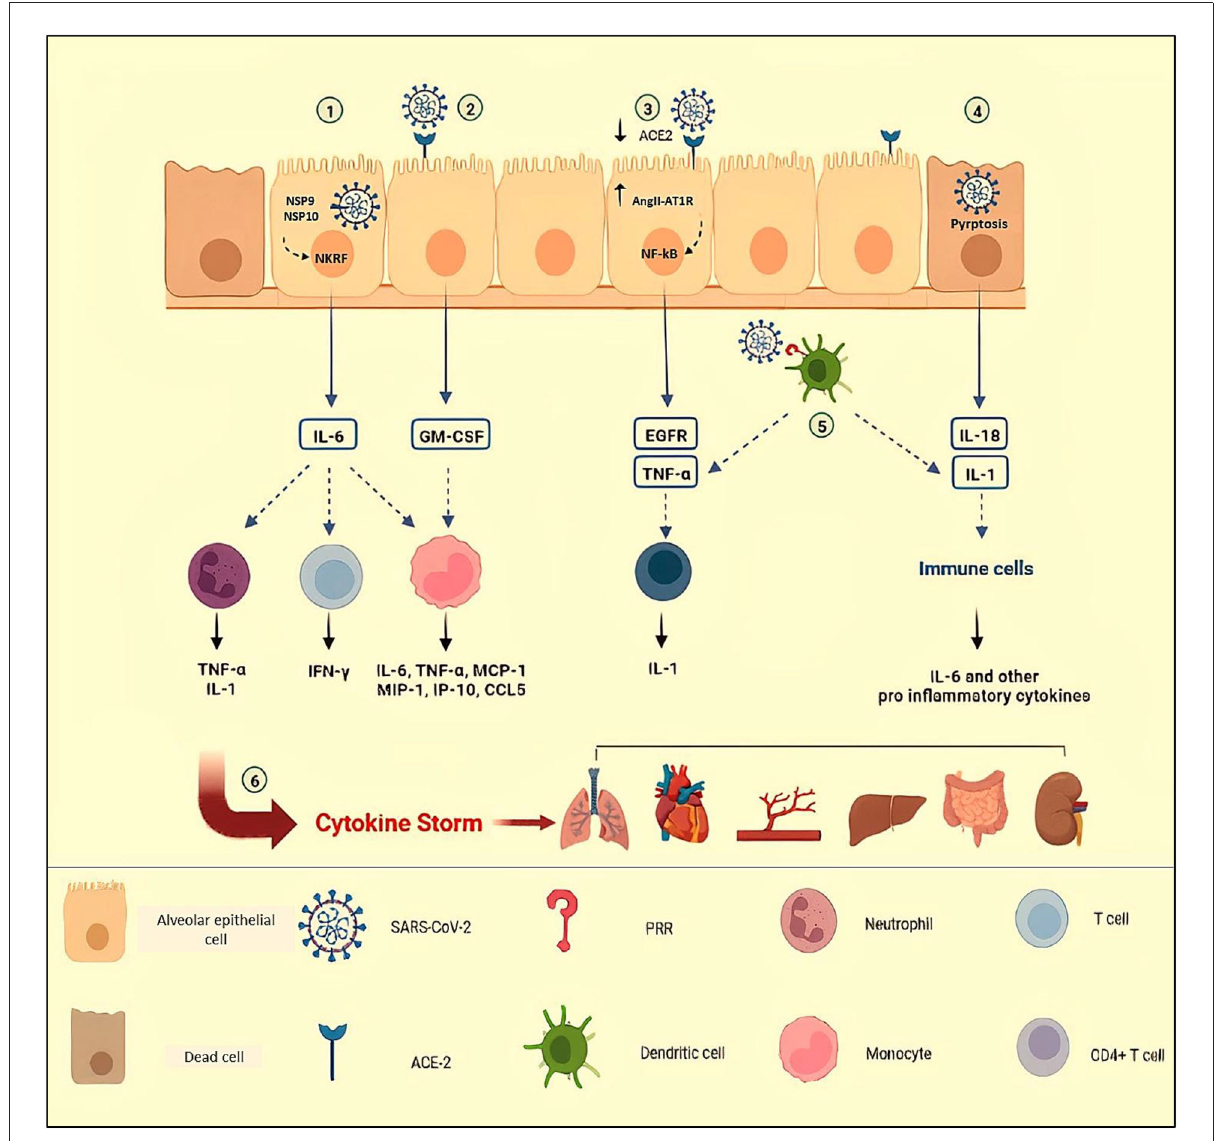
FIGURE1 Some mechanisms of cytokine storm in COVID-19. (1) NSP9 and NSP 10 of SARS-CoV-2 target NKRF to promote IL-6 production. By engagement of receptor with IL-6, IFN- γ and GM-CSF are secreted by activated T cells; MCP-1, MIP-1, MIP-1, IP-1O, and CCL-5 are secreted by activated monocytes; and neutrophils release pro-inflammatory cytokines such as TNF- α and IL-1. (2) In response to SARS-CoV-2 in epithelial cells, secreted GM-CSF activates CD14 + CD16 + monocytes to produce pro-inflammatory cytokines such as IL-6 and TNF- α . (3) Attachment of SARS-CoV-2 to ACE-2, leads to a reduction in ACE-2 expression and accumulation of AngII in the host cells. The AngII and its receptor (AT1R) complex activate NF- κ B, leading to the production of TNF- α and EGFR. (4) In COVID-19, increased levels of IL-1 β and IL-18 indicate inflammasome activation and pyroptosis of host infected cells, triggering inflammation by recruiting immune cells and pro-inflammatory cytokine production. (5) Dendritic cells that are triggered by PRRs release TNF- α and IL-1, causing acute inflammatory responses. TNF/TNFR interactions between effector CD4 + T cells and myeloid cells have been suggested to promote IL-1 β production. (6) Uncontrolled immune responses and hyperinflammation cause excessive production of pro-inflammatory cytokines, known as cytokine storms which are related to multi-organ failure and even death in COVID-19. NSP, Non-Structural Protein; NKRF, NF- κ B repressor; ACE-2, Angiotensin Converting Enzyme-2; AngII, Angiotensin II; AT1R, Angiotensin II Receptor type 1; PRR, Pattern Recognition Receptors Created in Biorender.com.